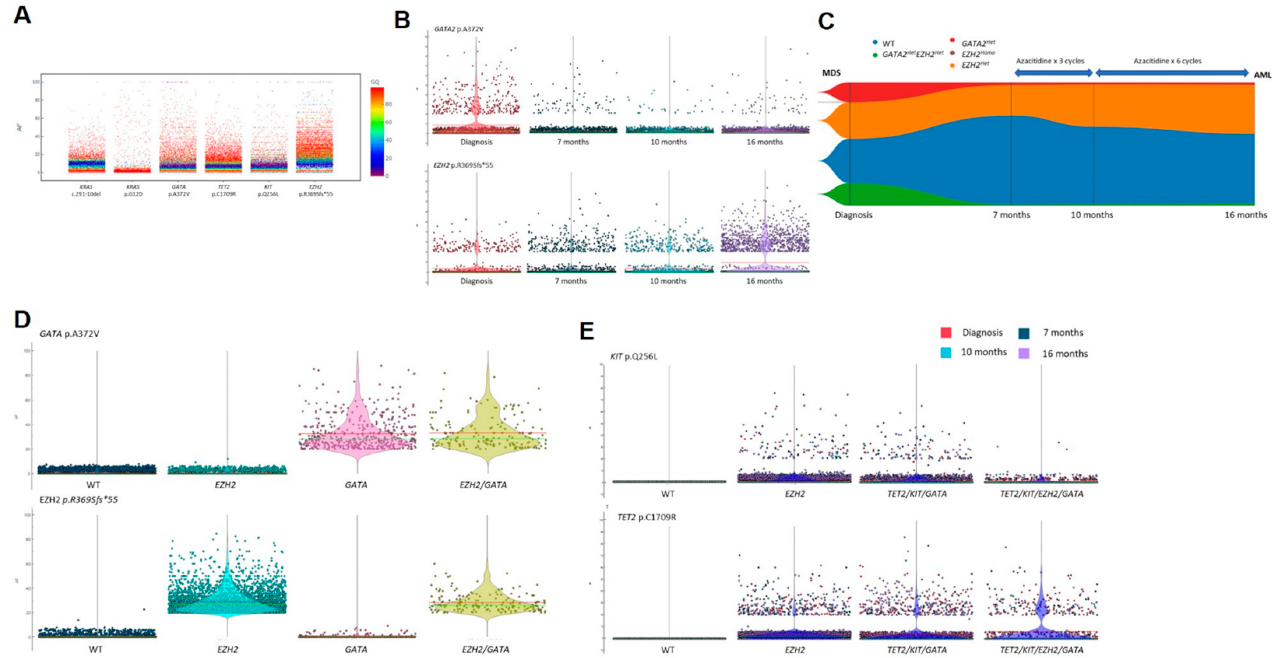
Figure 3. Detection and clonal evolutions of mutations in Patient 2. ( A ): VAFs and Quality of genotypes of rare pathogenic SNVs and INDELs which were present in <1% of total cells sequenced; ( B ): VAFs of major GATA2 and EZH2 mutations across different time points evaluated; ( C ): Fish plot evolution of WT, GATA2 , and EZH2 clones serially with treatment; ( D ): VAFs of EZH2 and GATA2 mutations at sub-clonal level; ( E ): VAFs of rare KIT and TET2 mutations in association with GATA2 and EZH2 mutations across different time points. Red and green lines on violin plots represented median and mean VAF, respectively while the color of each cell represented corresponding time points.